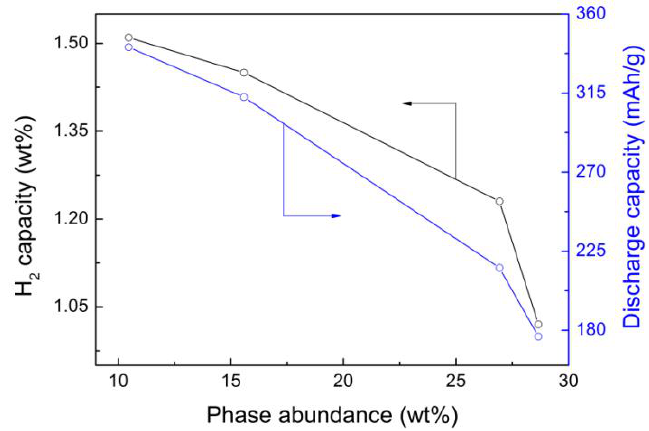
(Mg Zr )(Ni Co ) anodes. 0.7 0.3– x x 0.85 0.15 3.5